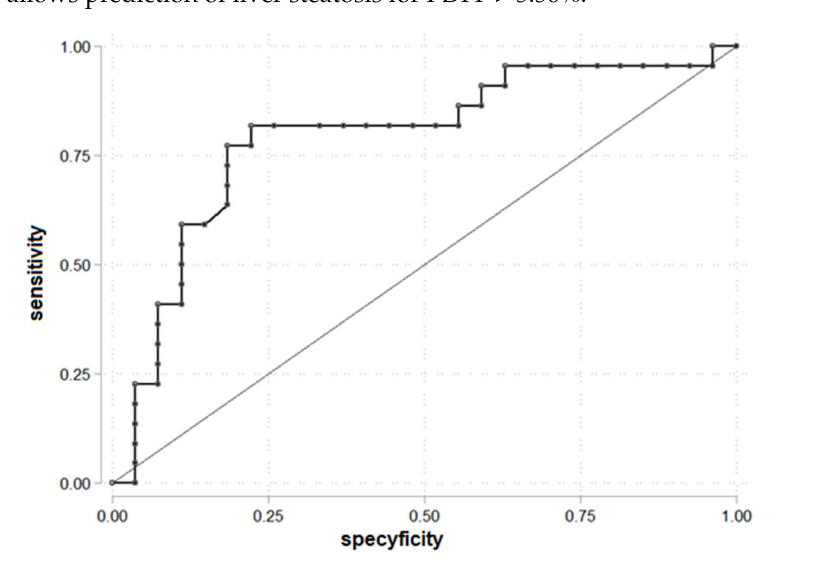
Figure 3. ROC curve for prediction PDFF > 5.56% according to the SHBG ( n =